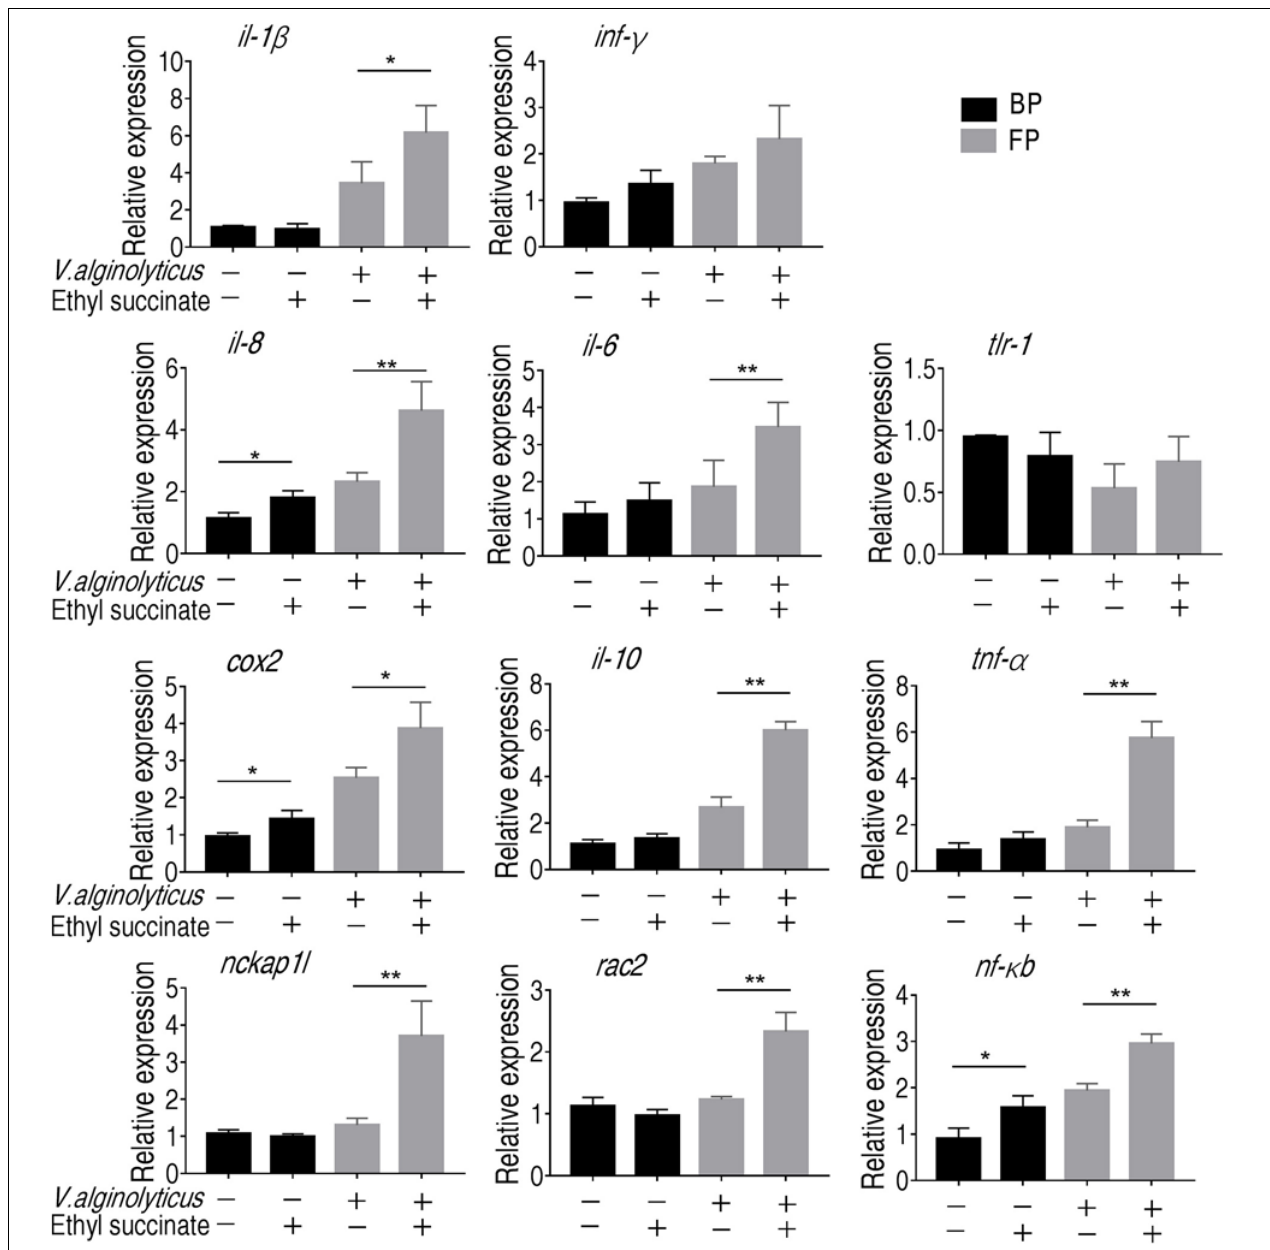
FIGURE 6 | Gene expression of monocytes/macrophages. qRT-PCR of the immune genes and phagocytic genes before and after phagocytosis. Error bars were represented as means ± SEM from three biological replicates. Statistical significance was obtained when * p < 0.05 or ** p <